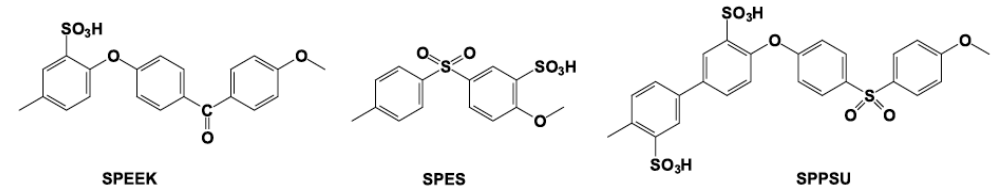
Figure 8. Chemical formulas of some sulphonated aromatic polymers.